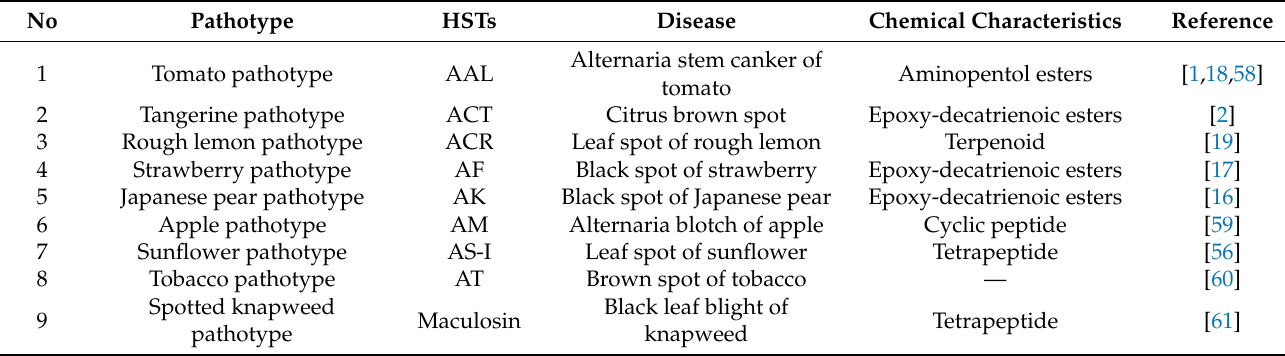
Table 2. HSTs produced by A. alternata